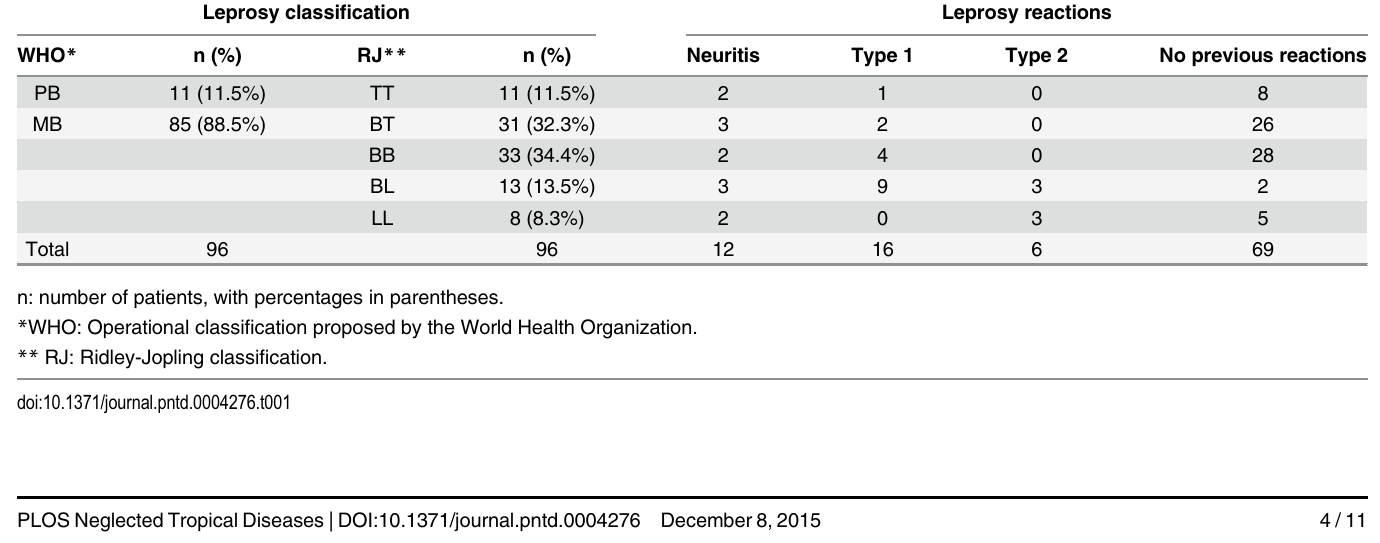
Table 1. Clinical data for the patients included in the study. Leprosy classi fi cation Leprosy